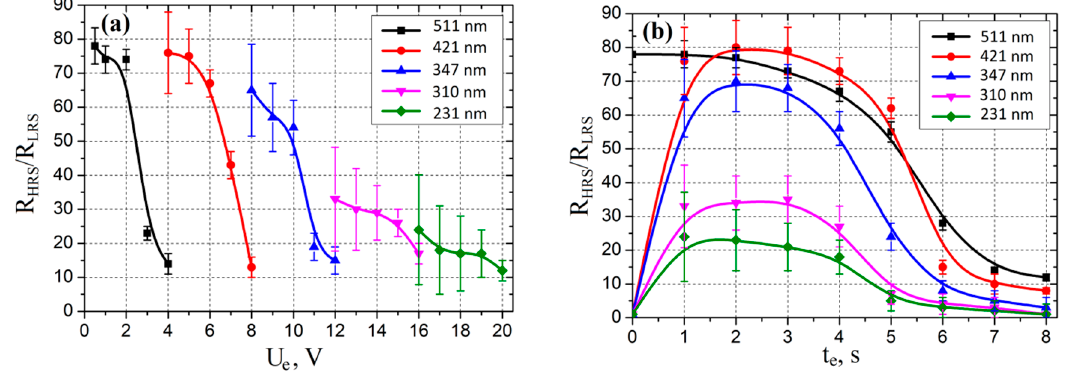
Figure 9. Experimental investigations of R HRS / R LRS ratio dependences on electroforming voltage ( a ) and electroforming time ( b ) at various grain